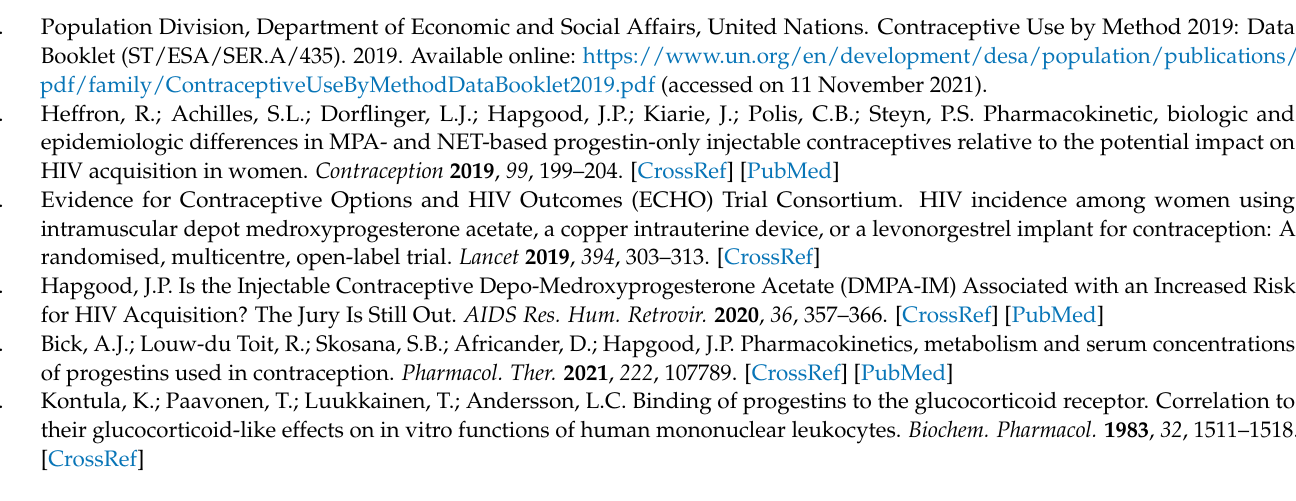
Figure S4: kinetics of cytokine production in HIV-infected tonsillar tissue explants treated with steroid hormones